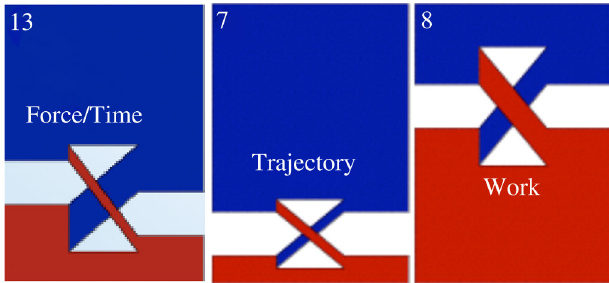
FIG. 1. Three Kanim escalator graphs, for questions about Force and Time, Trajectories, and Work. In each, percentage of students answering correctly before and after instruction is indicated, as well as change from correct to incorrect and incorrect to correct. Figures are provided by Kanim